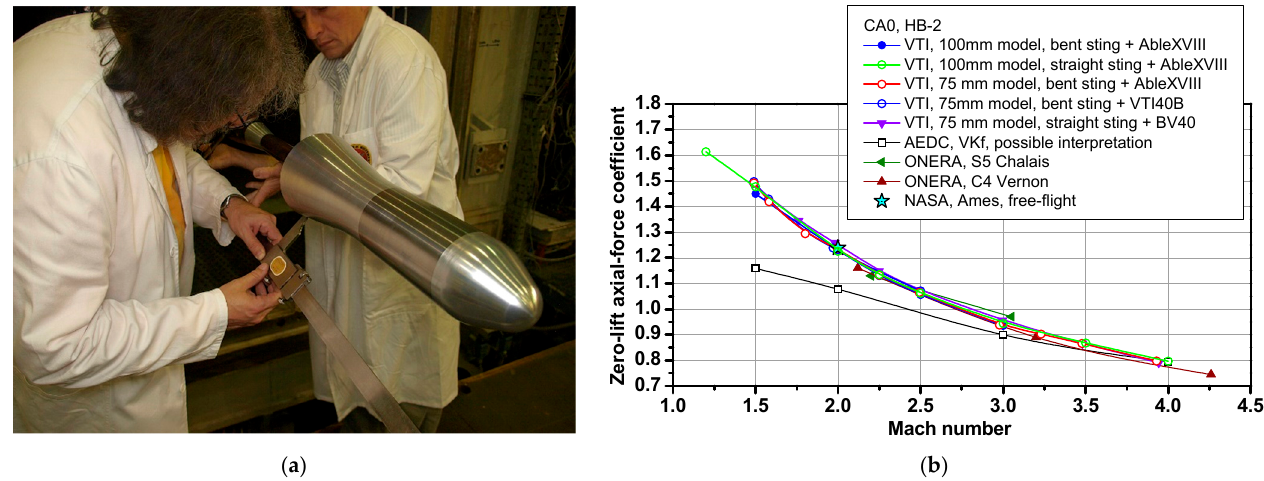
Figure 13. ( a ) The 100 mm diameter HB − 2 standard model in the T-38 wind tunnel; ( b ) results of the HB − 2 model obtained in the T-38 wind tunnel correlated with those from AEDC, ONERA and NASA Ames [40,41,47,53–55]; the test has been extended to the transonic part of the T-38 operating envelope.